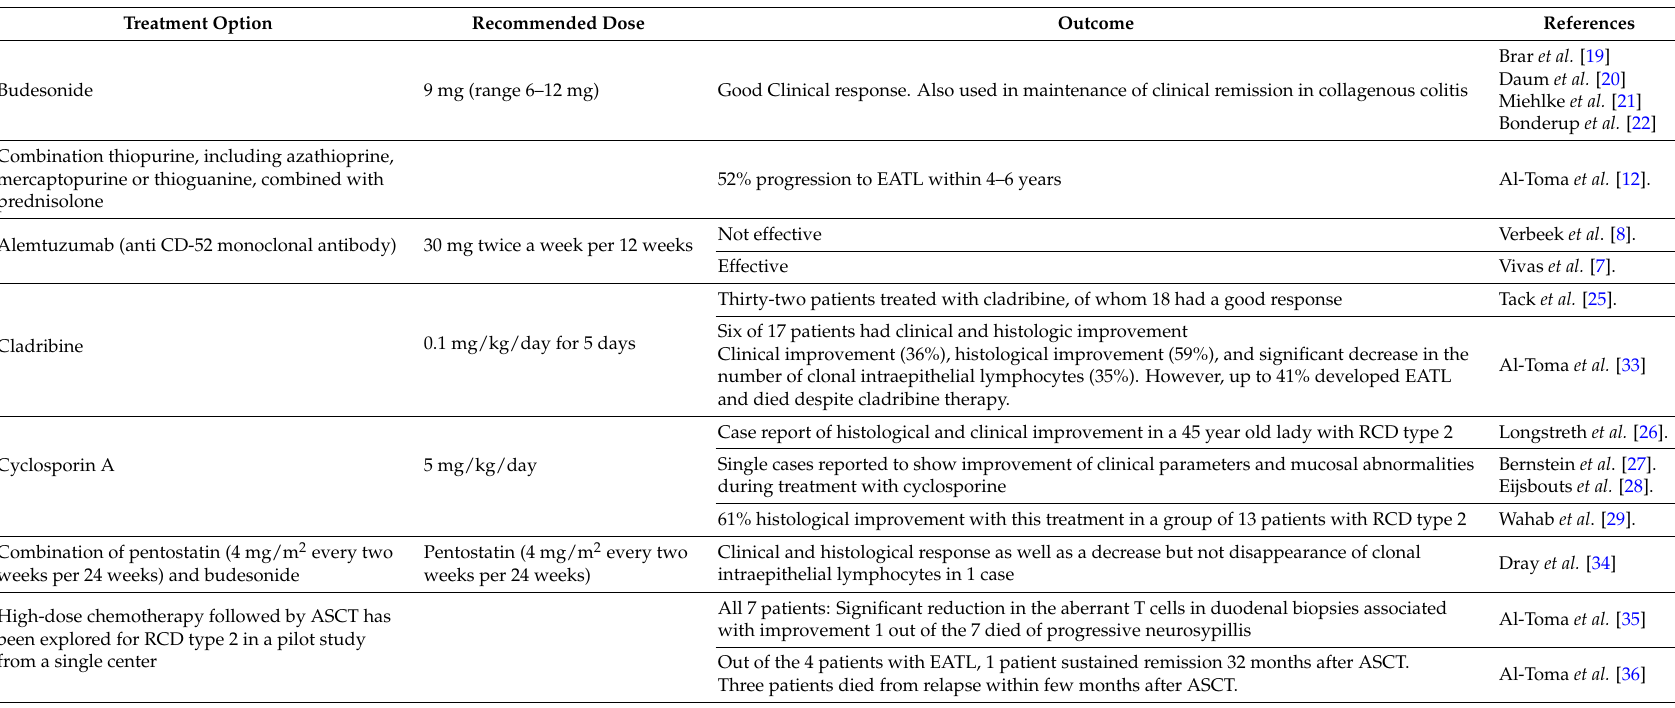
Table 5. Treatment options in RCD type